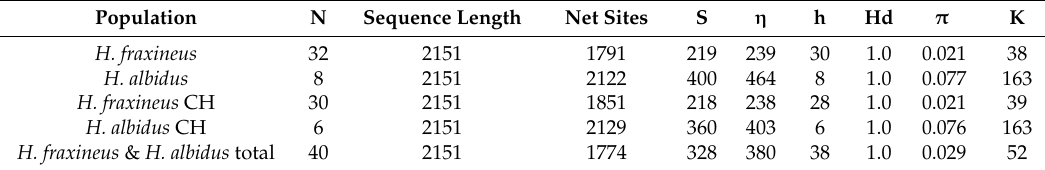
Table 2. Population genetic parameters for the full length RdRP gene sequences (2151 bp) of HfMV1 recovered from Hymenoscyphus albidus and H. fraxineus .